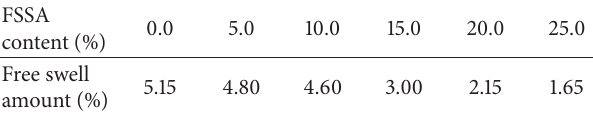
Table 5: Effect of the FSSA additive content on the free